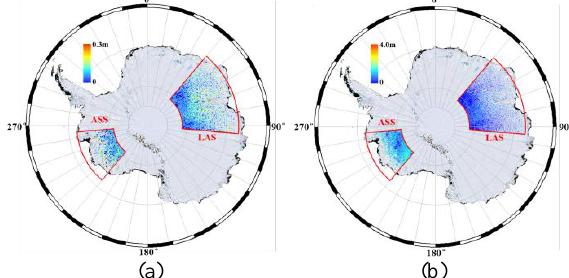
Figure 2. (a) precison of ICESat in LAS and ASS; (b) precison of Envisat in LAS and ASS.